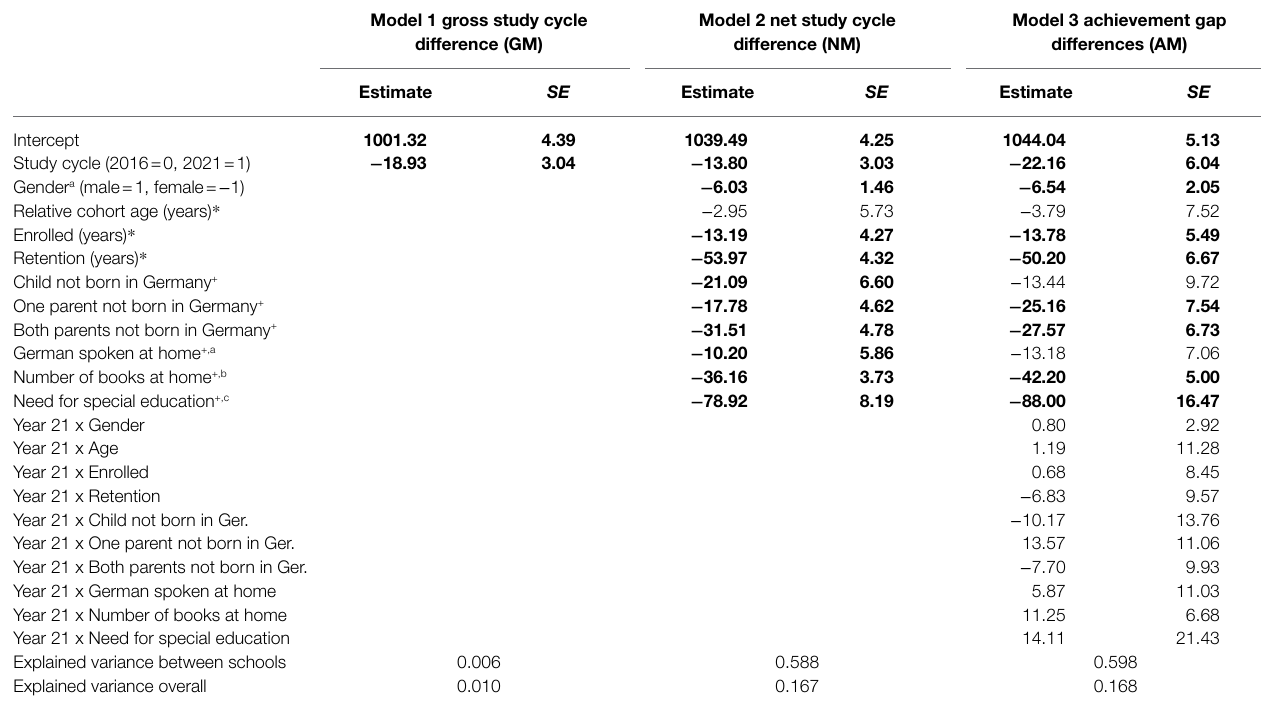
TABLE 1 | Linear mixed-effect model explaining reading